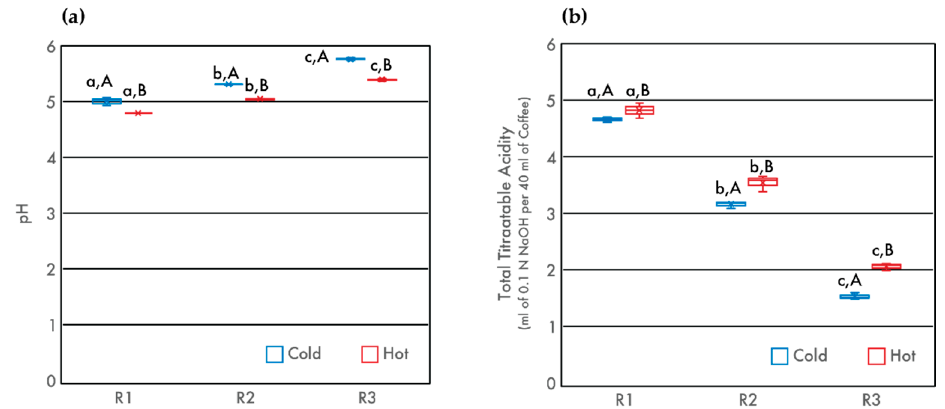
Figure 1. pH ( a ) and total titratable acids (TTA) ( b ) of cold and hot brew co ff ee samples as a function of degree of roast. Letters a–c denote significant ( p < 0.05) di ff erences among degrees of roast within the same brewing method as determined by the Tukey HDS post-tests. Letters A and B denote significant di ff erences between cold and hot brewing methods at the same degree of roast.